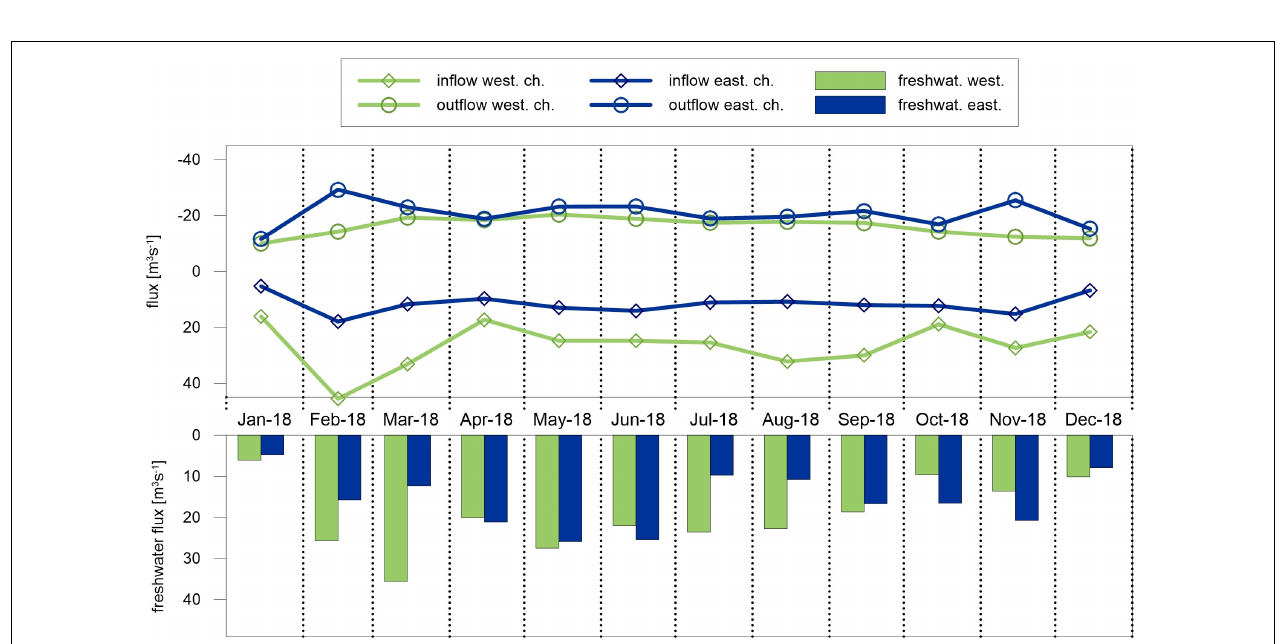
FIGURE 11 | Average volume fluxes in the inlet channels, distinguished by inflow positive (in the deeper layers) and negative outflow in the surface layer. The average freshwater inputs in the lagoon are considered positive. The western freshwater is the sum of the Po of Volano and the pumping stations Giralda (G), Romanina (R), and Bonello (B) ( Figure 1 ), The eastern freshwater is the sum of the volume fluxes at the Manufatto gate and Gorino lock.